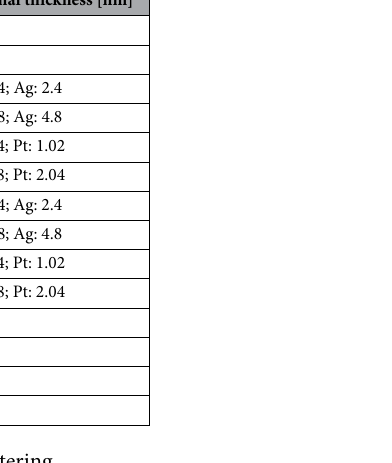
Table 1. Thin film surfaces prepared by magnetron